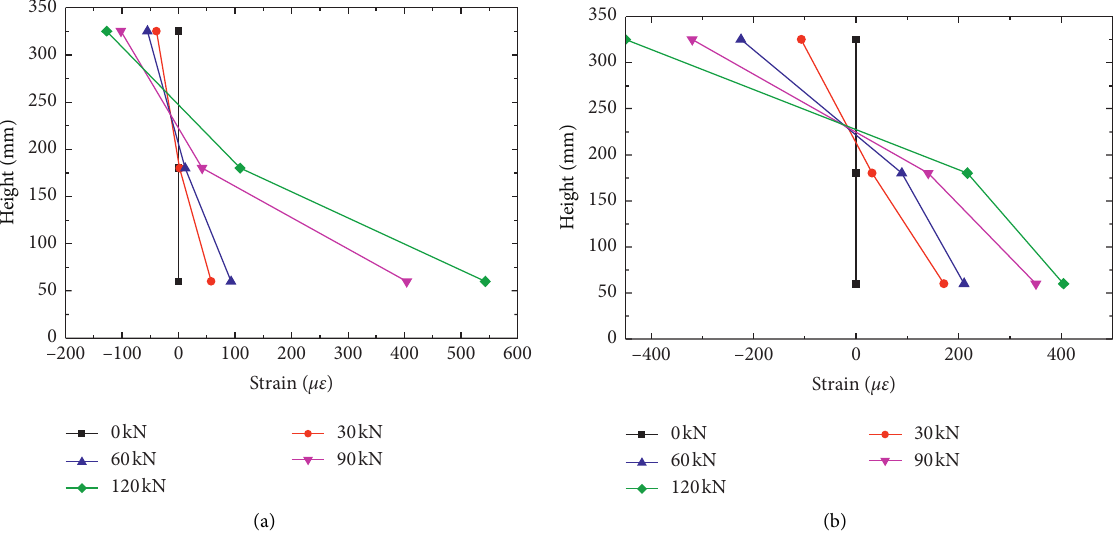
Figure 9: Strain distribution along girder heights (specimen 1): (a) mid-span cross section (section 1); (b) cross section near shear keys (section 2).